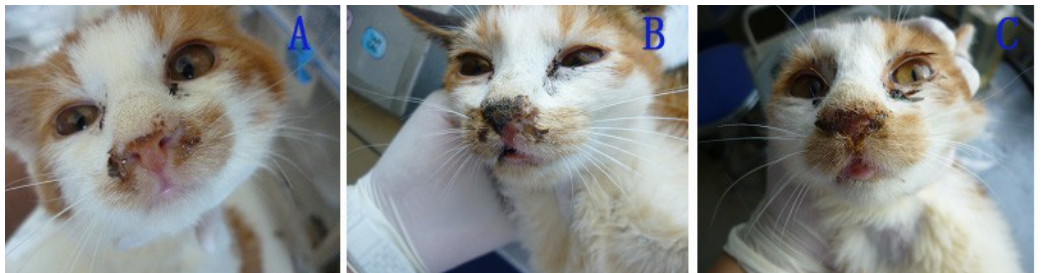
Figure 5. Nasal signs of cats infected with FHV-1: secretion of thin nasal discharge ( A ); purulent secretion ( B ); blocked nostrils ( C